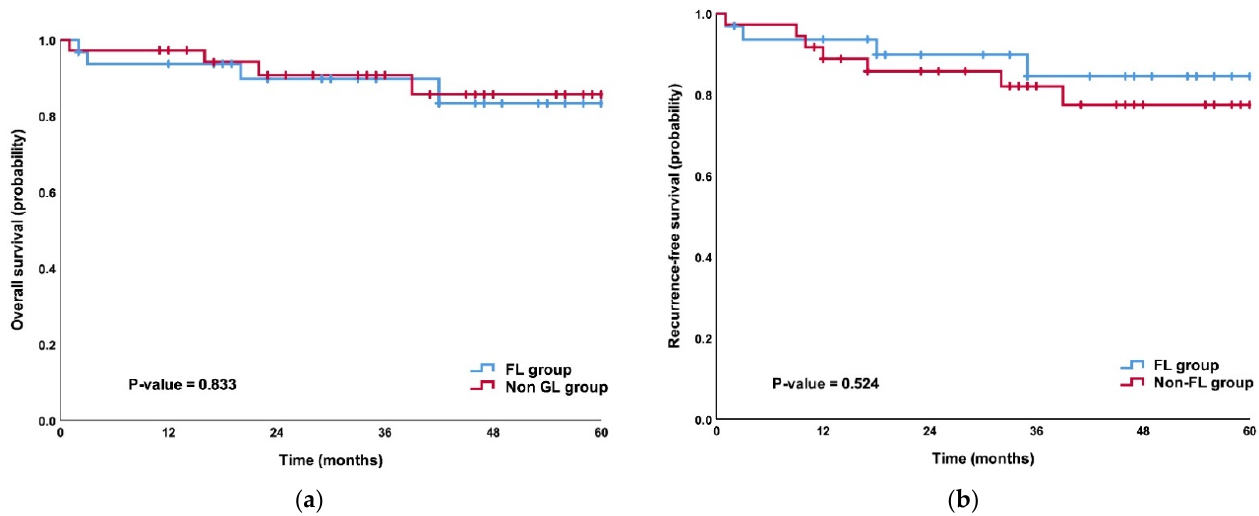
Figure 3. Kaplan–Meier estimates of the probability of all patients’ ( a ) overall survival and ( b ) re- lapse-free survival. free